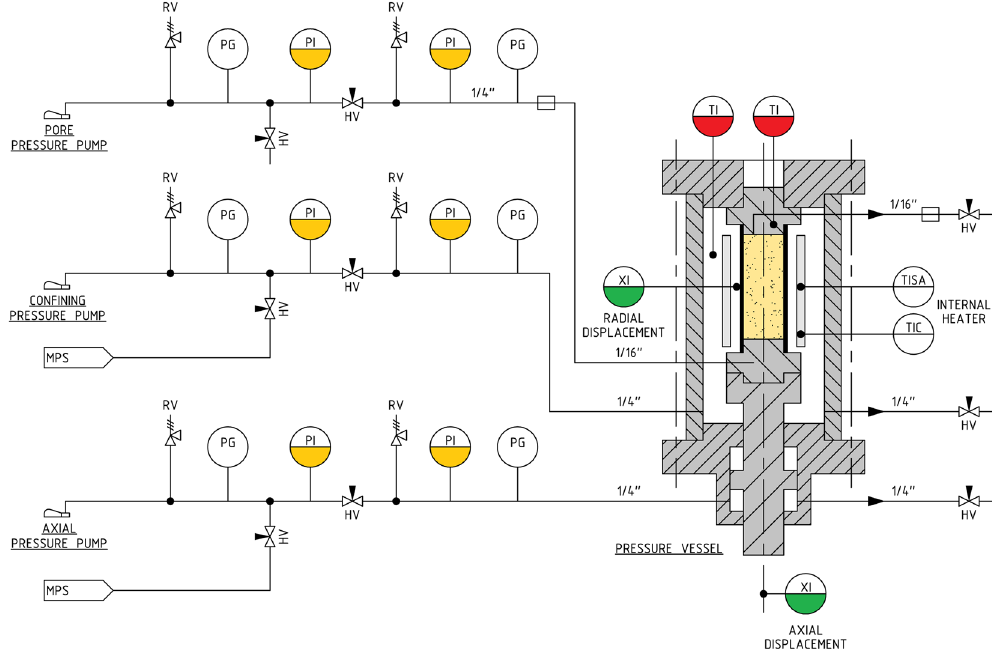
Figure 7. Schematic drawing of a set-up used to perform pore pressure depletion testing using 1 ′′ diameter samples. The vessels used for testing 1.5 ′′ diameter samples are similar in design, with the only difference that the axial loading piston is sized to 1.5 ′′ diameter. The pressure vessel is capable of heating up to 120 °C. The axial pressure (S ax ), confining pressure (S rad ) and pore pressures (P p ), can be applied up to 110 MPa. Abbreviations used are RV = Relief Valve, HV = Hand Valve, MPS = Mobile Pressurization System, PG = Pressure Gauge, PI = Pressure Indicator, TI = Temperature Indicator, XI = Displacement Indicator, TISA = Temperature Indicator Switch Alarm, TIC = Temperature Indicator